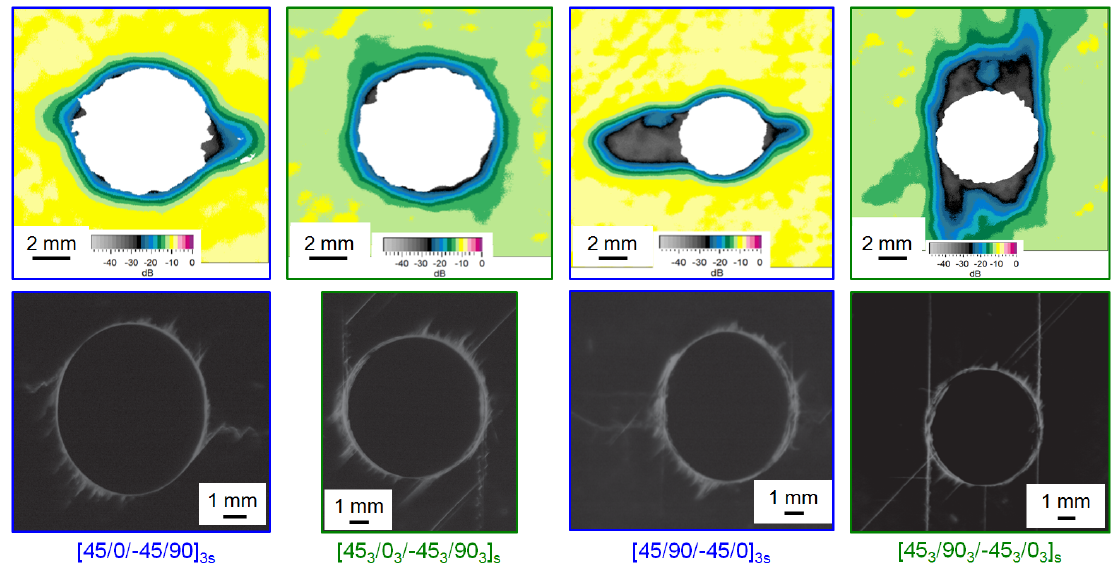
Figure 5. C-scan back-wall echo and X-ray images of failure initiation at approx. 0.7 % strain for representative OHC